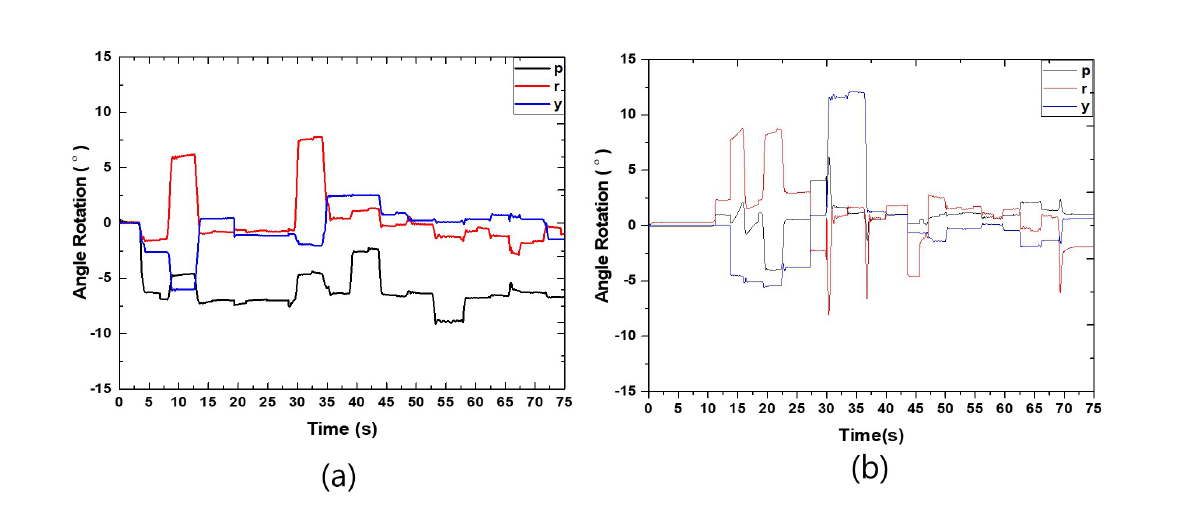
Figure 11. IMU results during the walking test of the combined status for ( a ) Robot 1 and ( b ) Robot